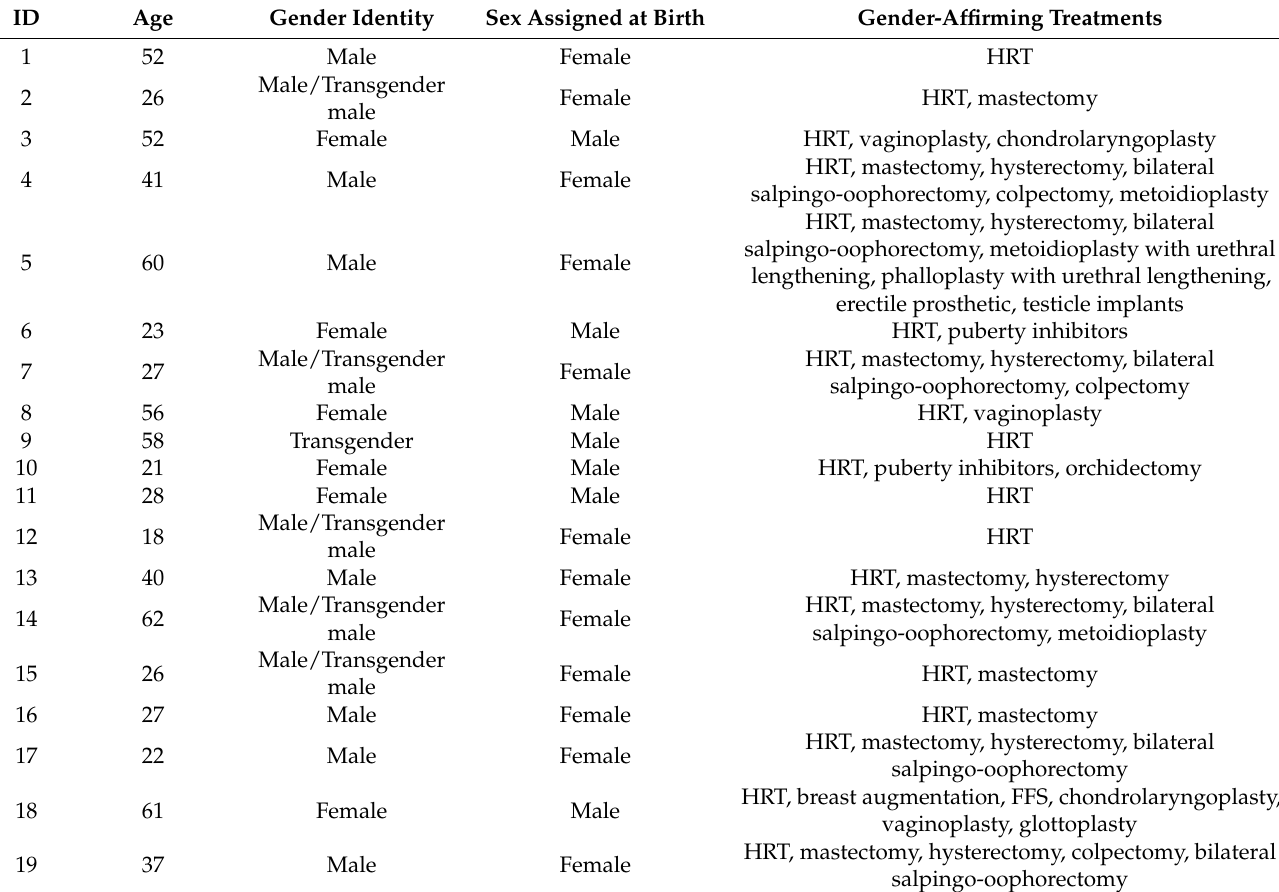
Table 1. Participant